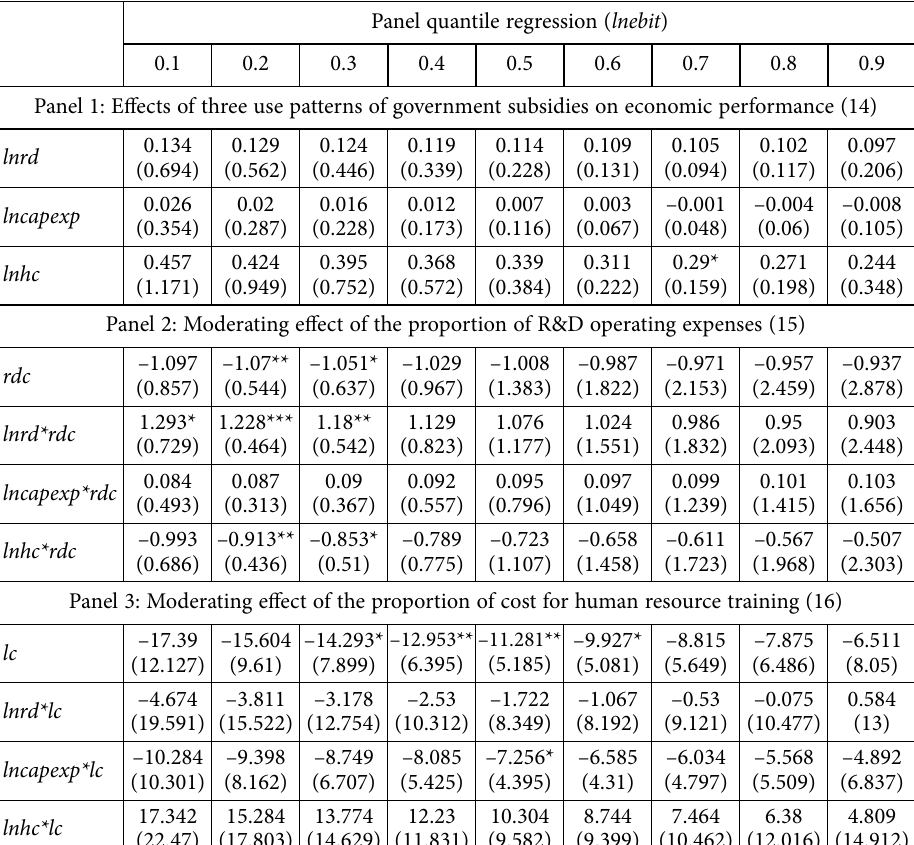
Table 3. Results of panel quantile